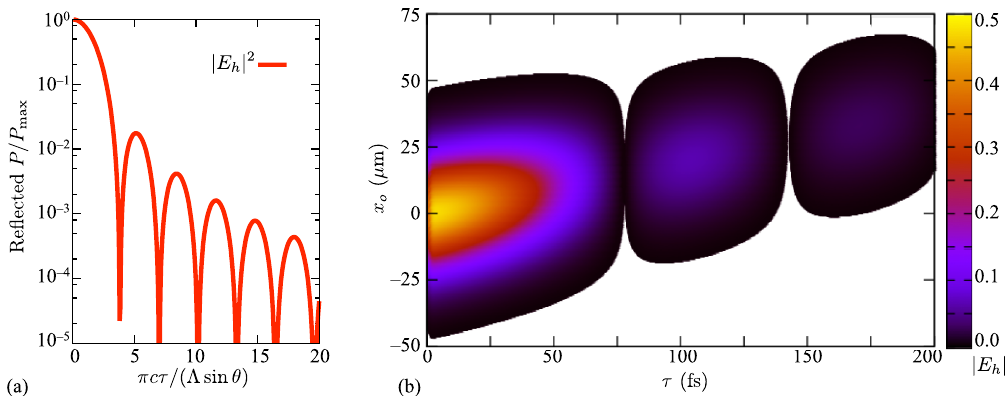
TIME DEPENDENCE OF BRAGG FORWARD SCATTERING . .